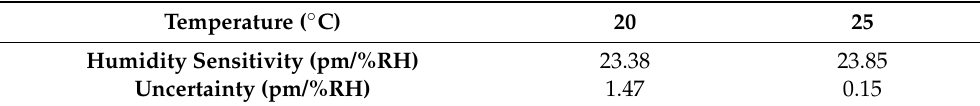
Table 2. Humidity sensitivity (pm/%RH) of the polymer sensor at 20 and 25 ◦ C.